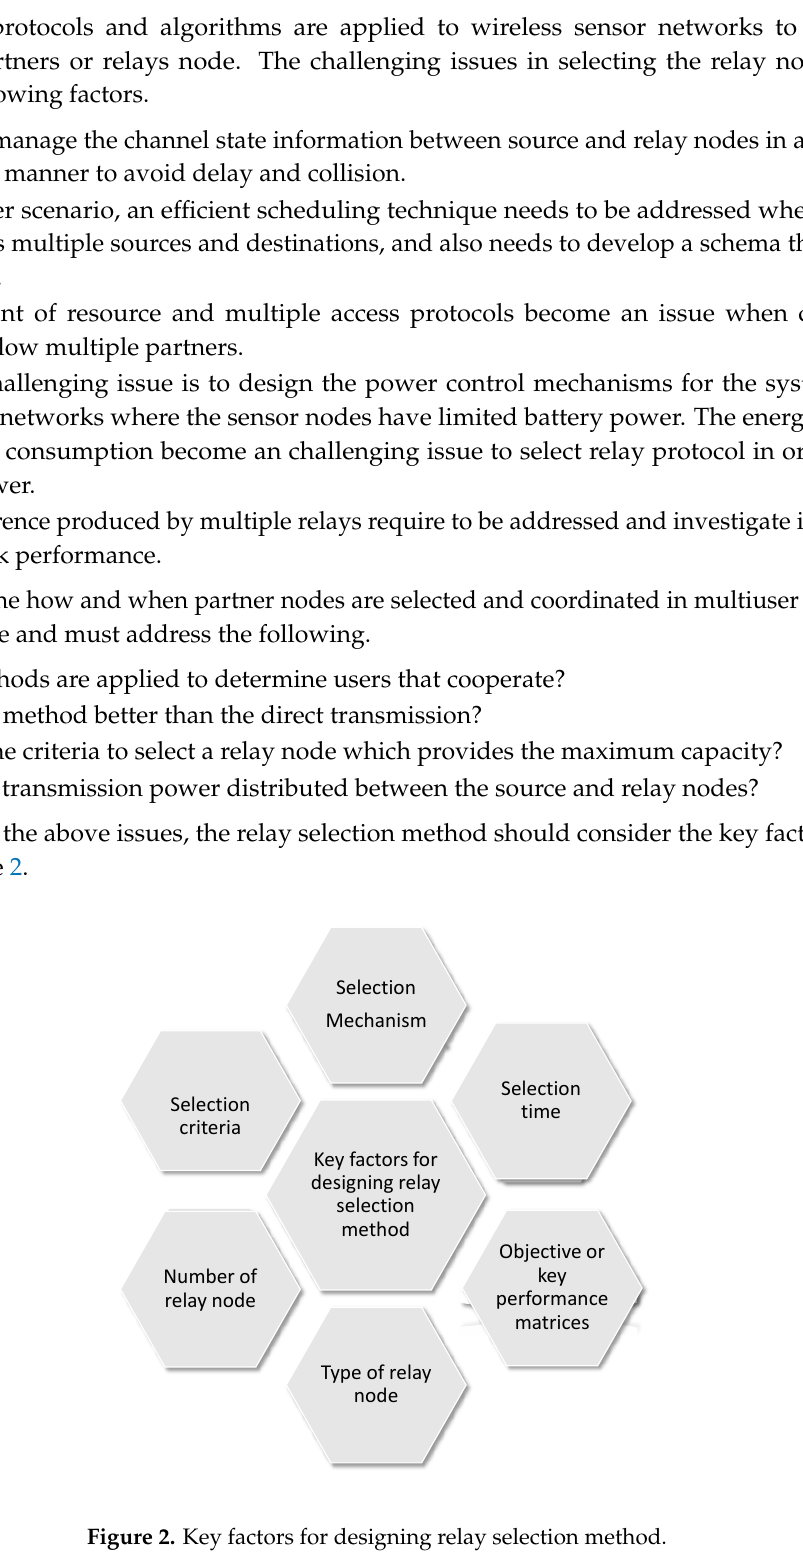
Figure 2. Key factors for designing relay selection